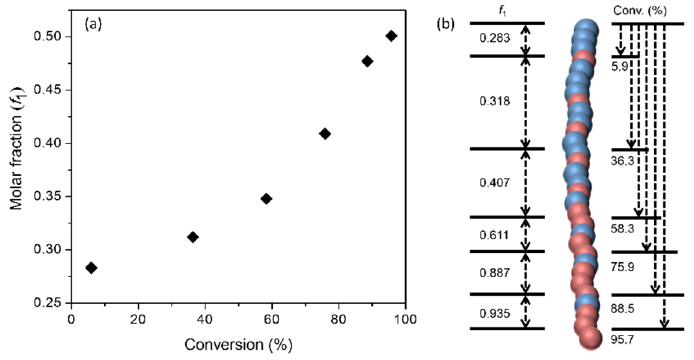
Figure 1. ( a ) Molar fraction ( f 1 ) of 3 in the copolymers vs. monomer conversion and ( b ) schematic representation of gradient polymer structures. Copolymerization: [ I ]:[3]:[EtOx] = 1:50:50; the monomer representation of gradient polymer structures. Copolymerization: [ I ]:[ 3 ]:[EtOx] = 1:50:50; the conversion was monitored with 1 H NMR monomer conversion was monitored with 1 H NMR spectroscopy.